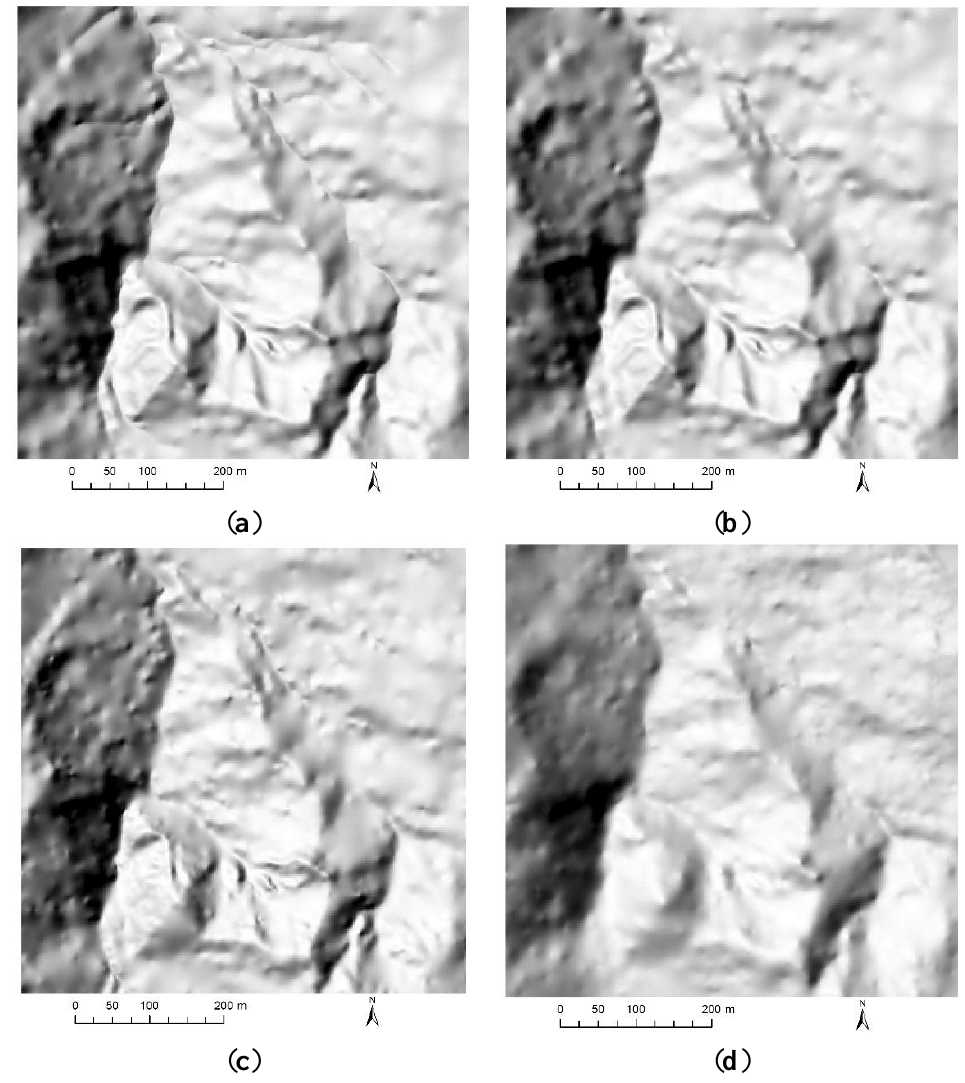
Figure 7. Hillshades of ( a ) TPS-F, ( b ) TPS-W, ( c ) max-Z and ( d ) random with1% of LiDAR points in the undulating site.